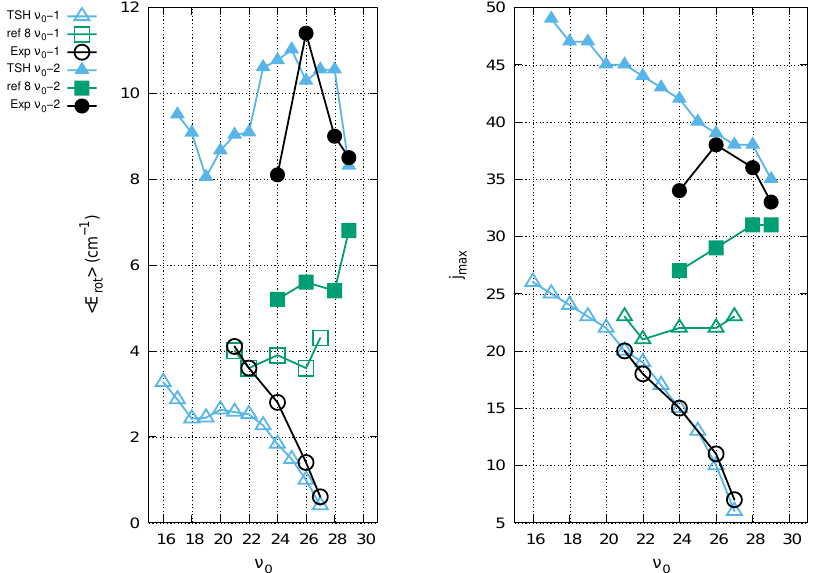
Figure 7. Average rotational energy [ (cid:104) E rot (cid:105) cm − 1 ] and the maximum orbital angular momentum ( j max ) (see reference [8] to compute j max